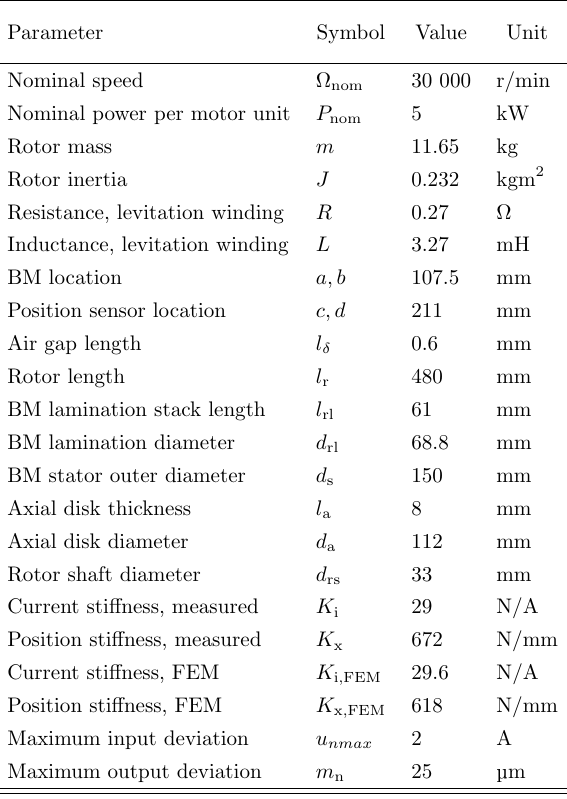
Table 1: Machine